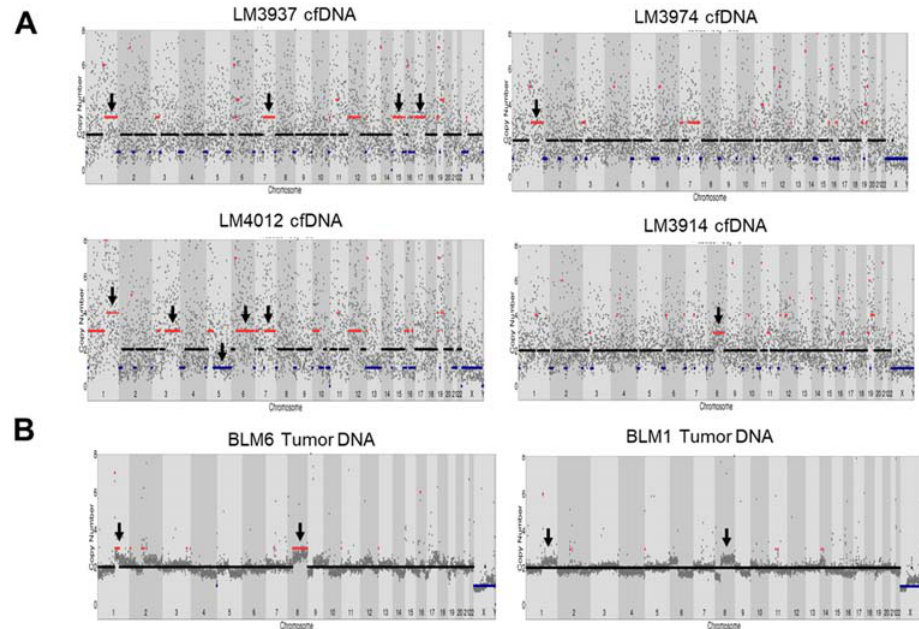
Figure 4. Copy number variants detection in HCC cfDNA and tumor DNA using whole-exome sequencing (WES) and Oxford nanopore sequencing. ( A ) CNVs in HCC cfDNA from LM3937, LM3974, LM4012, and LM3914 using WES. ( B ) CNVs in tumor DNA using Oxford nanopore sequencing.